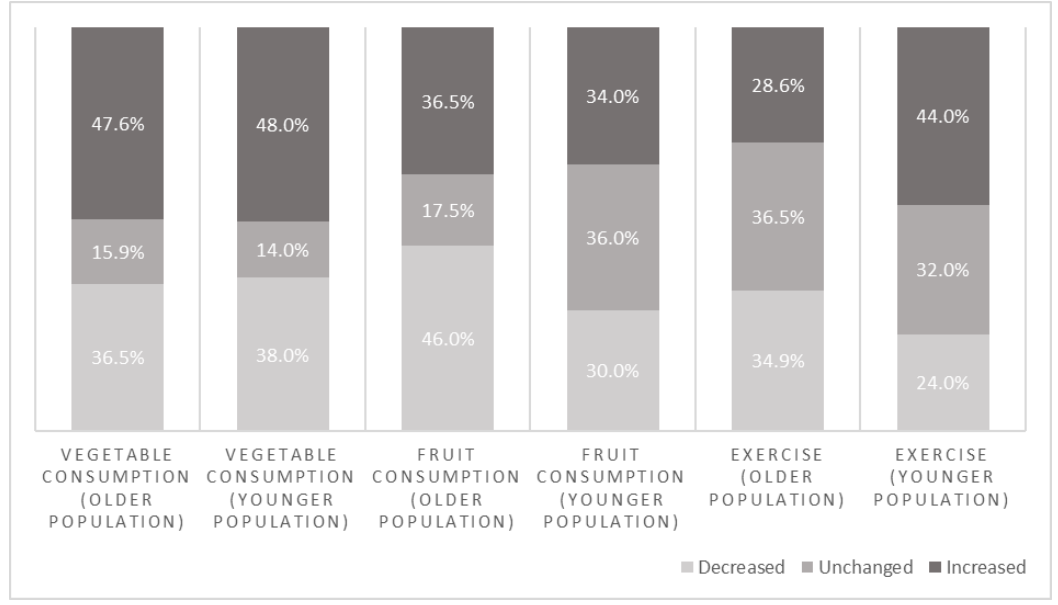
Figure 3. Percentages of categorical change in lifestyle behaviors between T0 and T1 within two age groups.